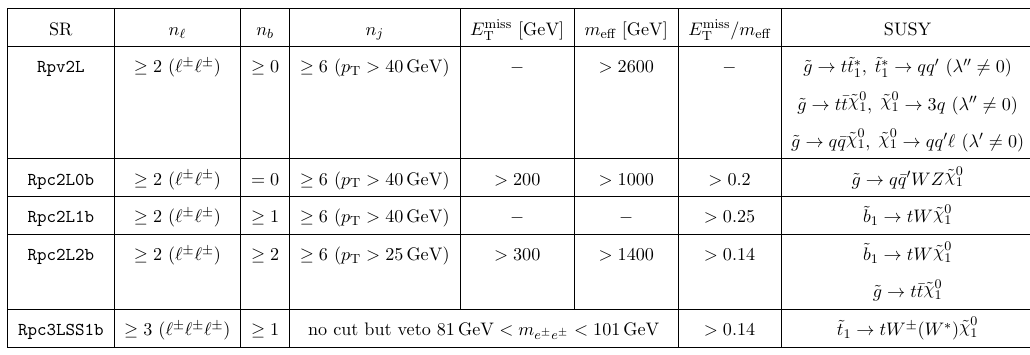
Table 1. De(cid:12)nition of the signal regions used by the analysis, based on the variables de(cid:12)ned in section 4. The last column provides examples of SUSY processes which may contribute to these signal